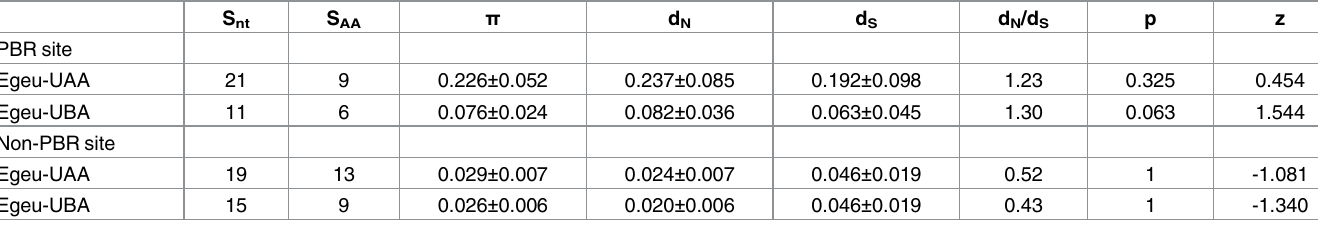
Table 2. Summaryof sequence variation of MHC class I in the Chinese egret.